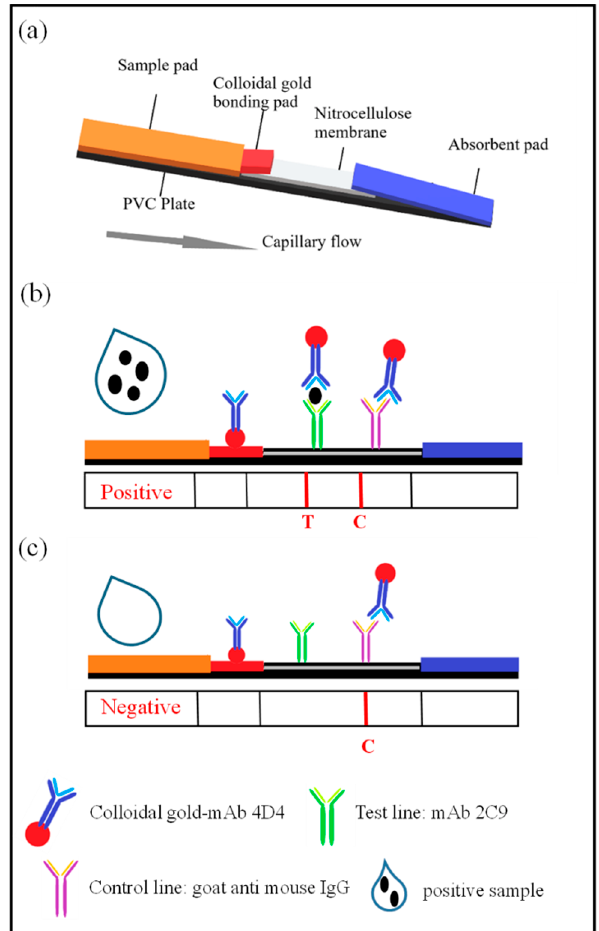
Figure 1. Characterization of the test results. ( a ) Schematic diagram of the test strip structure. ( b ) The reaction that occurs with the mAbs 4D4–2C9 in the presence of the CGMMV antigen. ( c ) In the absence of the CGMMV immunogen in the sample, the reaction only occurs on the control (C) line.